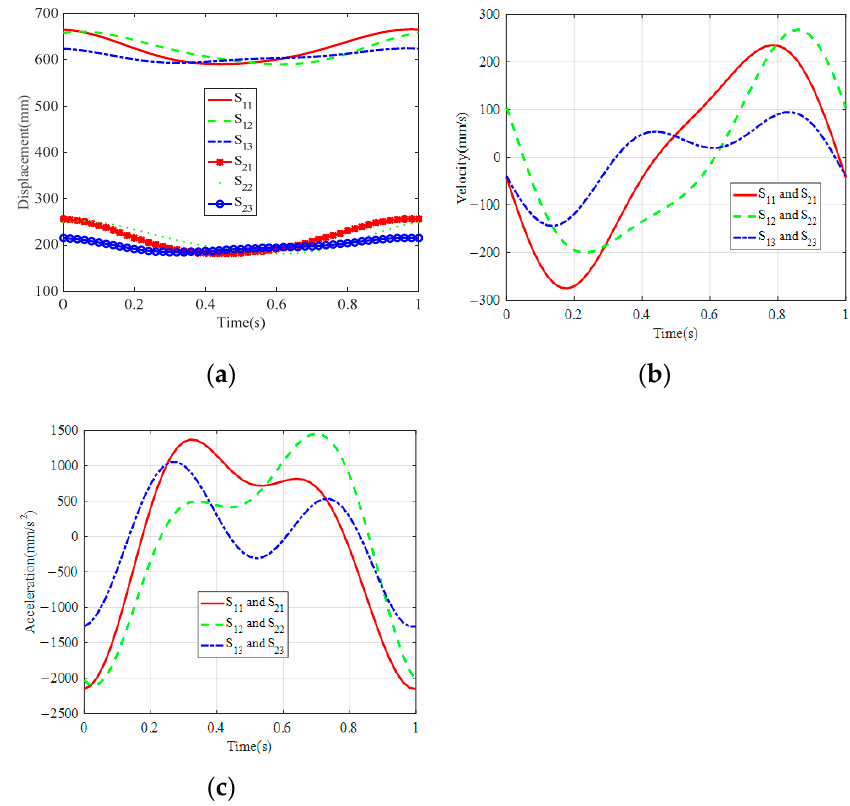
Figure 6. Motion curves of the slider. ( a ) Displacement; ( b ) Velocity; ( c ) Acceleration.